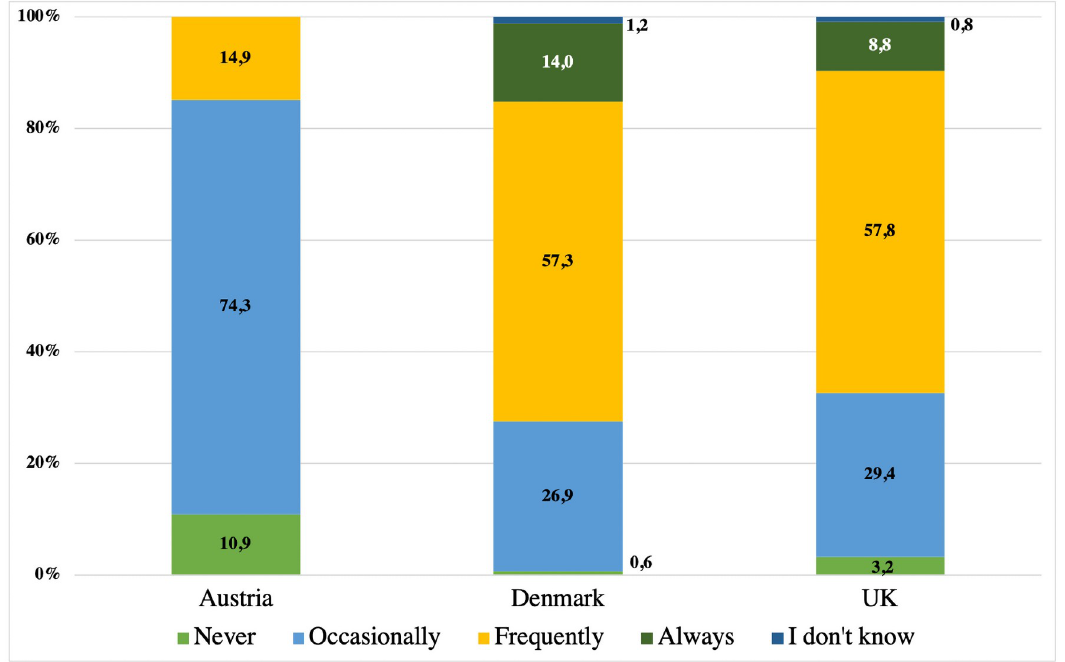
Fig 1. Frequency of discussions among veterinarians and dog and cat owners about the possibility of health insurance in Austria (n = 101), Denmark (n = 171) and the UK (n = 374).